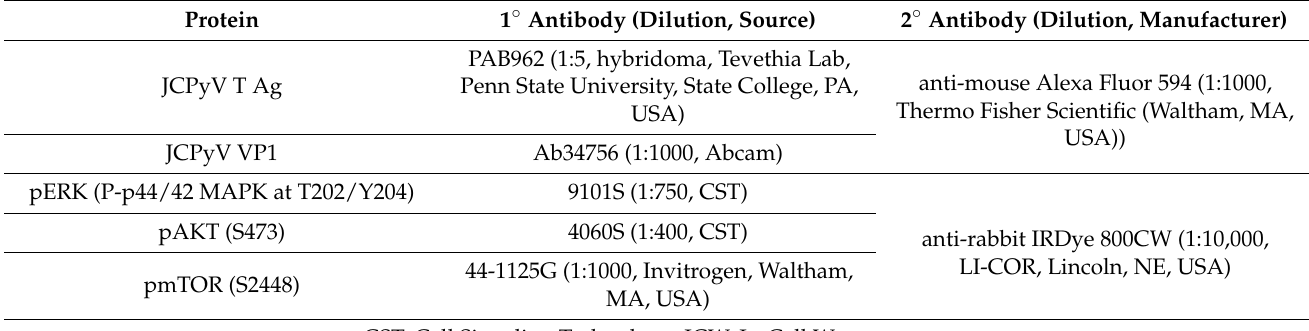
Table 1. Antibodies used in immunofluorescence and ICW